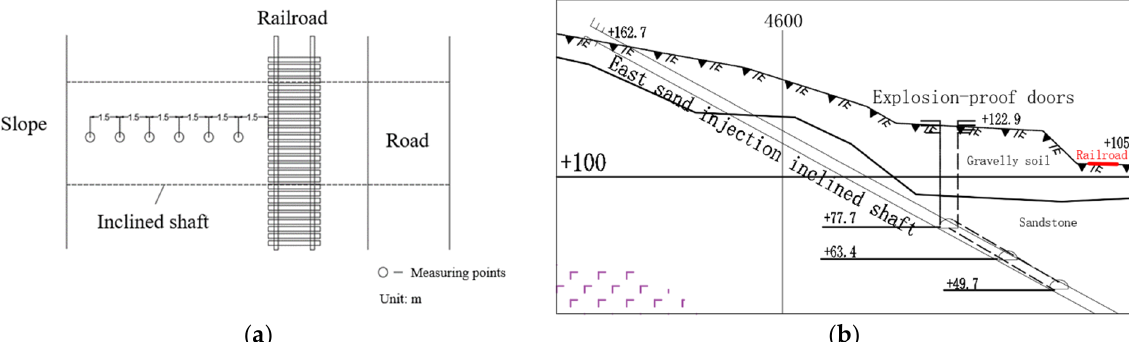
Figure 2. Monitoring location diagram. ( a ) Schematic diagram of the measuring point layout. ( b ) Cross-sectional view of monitoring location.